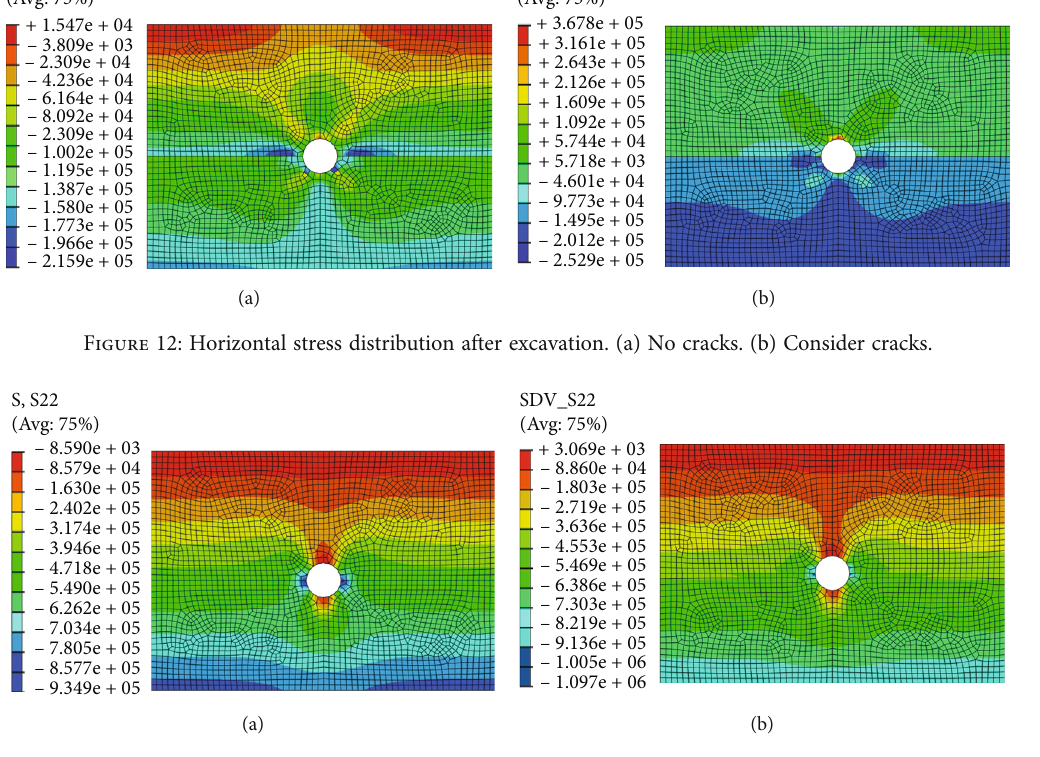
Figure 13: Vertical stress distribution after excavation. (a) No cracks. (b) Consider